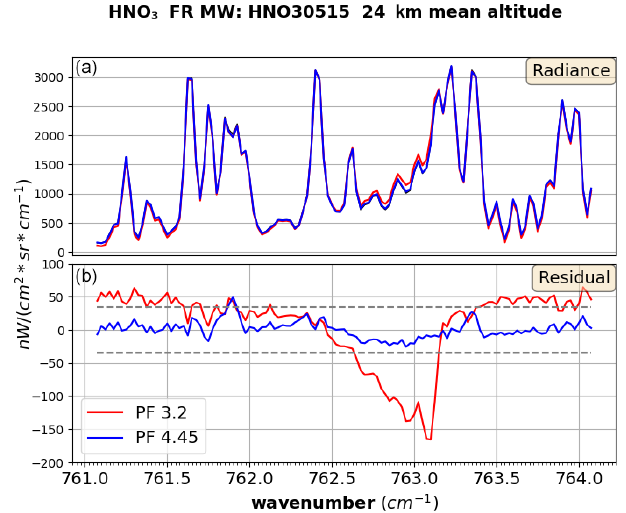
Figure 7. (a) Observed spectrum (black curve, under the blue one) and simulations at a limb tangent height of 24km with the old (red curve) and the new (blue curve) spectroscopic parame- ters for a microwindow used for HNO 3 retrieval of FR measure- ments. (b) Residuals obtained with simulations generated with the old spectroscopic database (red curve) and the new one (blue curve), compared with the measurement noise (grey curves).